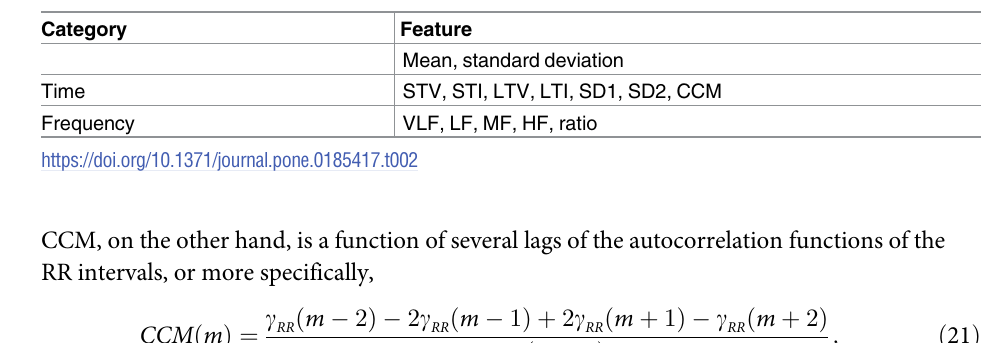
Table 2. List of all the